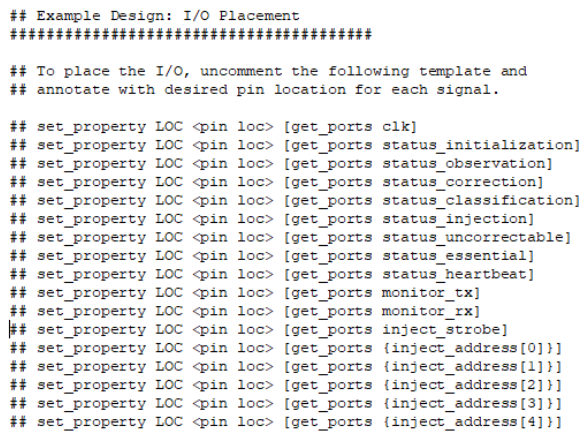
Figure 13. Original SEM IP constraint file.